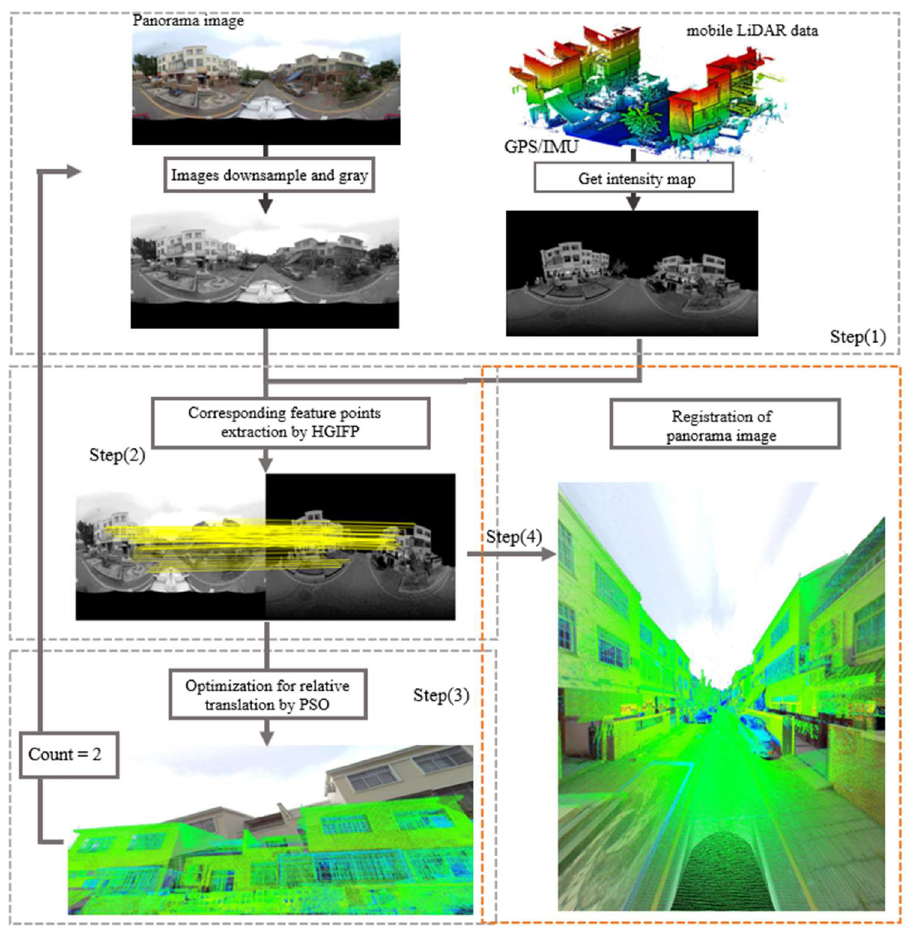
Figure 1. The framework of the registration process.